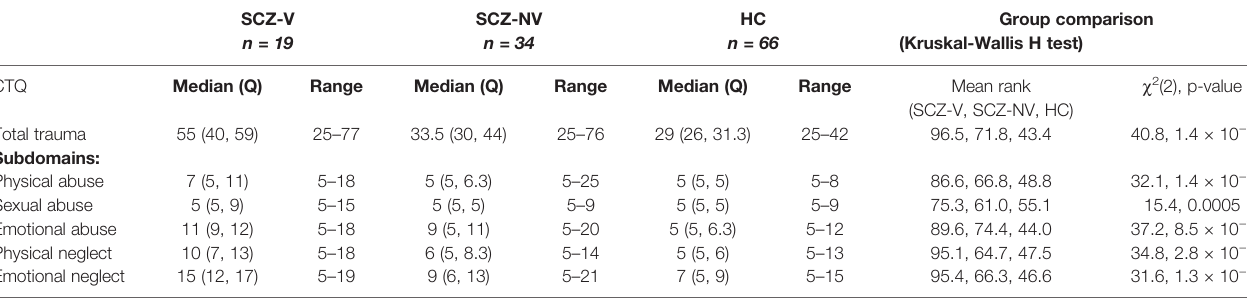
TABLE 2 | Childhood trauma in patients with (SCZ-V) and without (SCZ-NV) a history of violence, and healthy controls